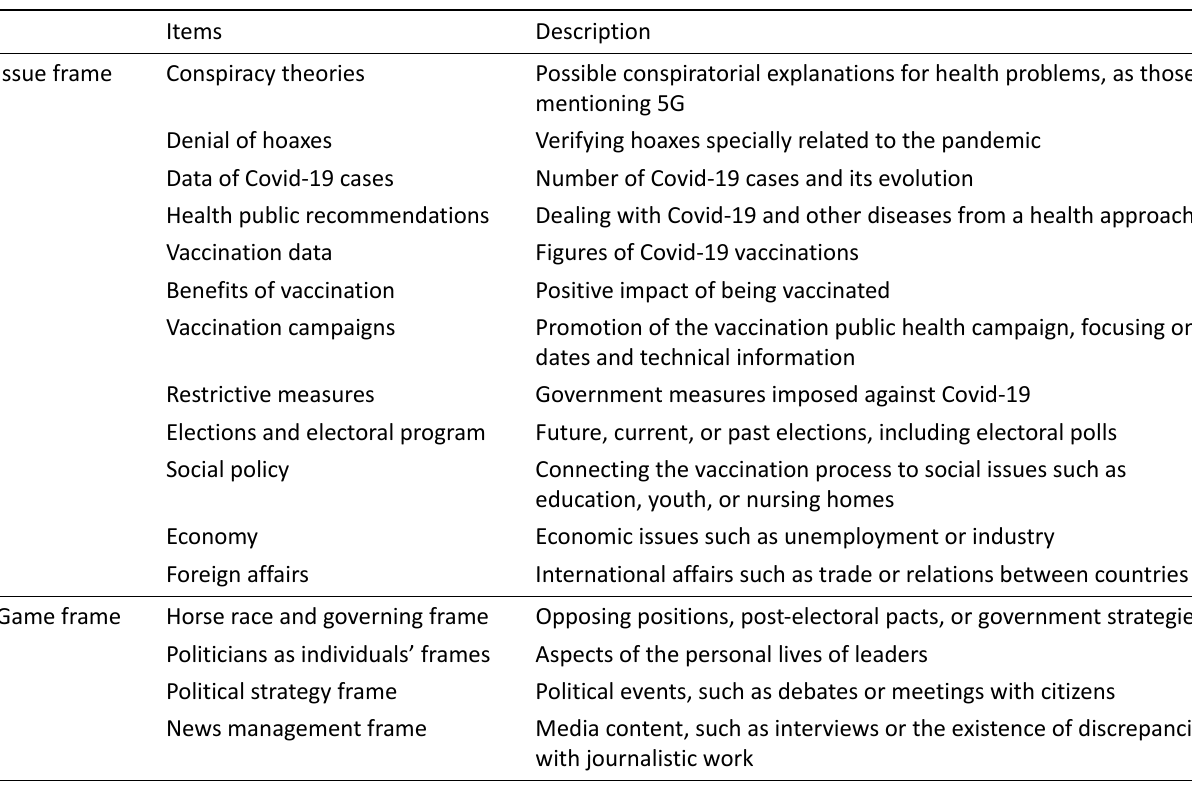
Table 1. Categories used for the quantitative study of the agenda on Twitter.